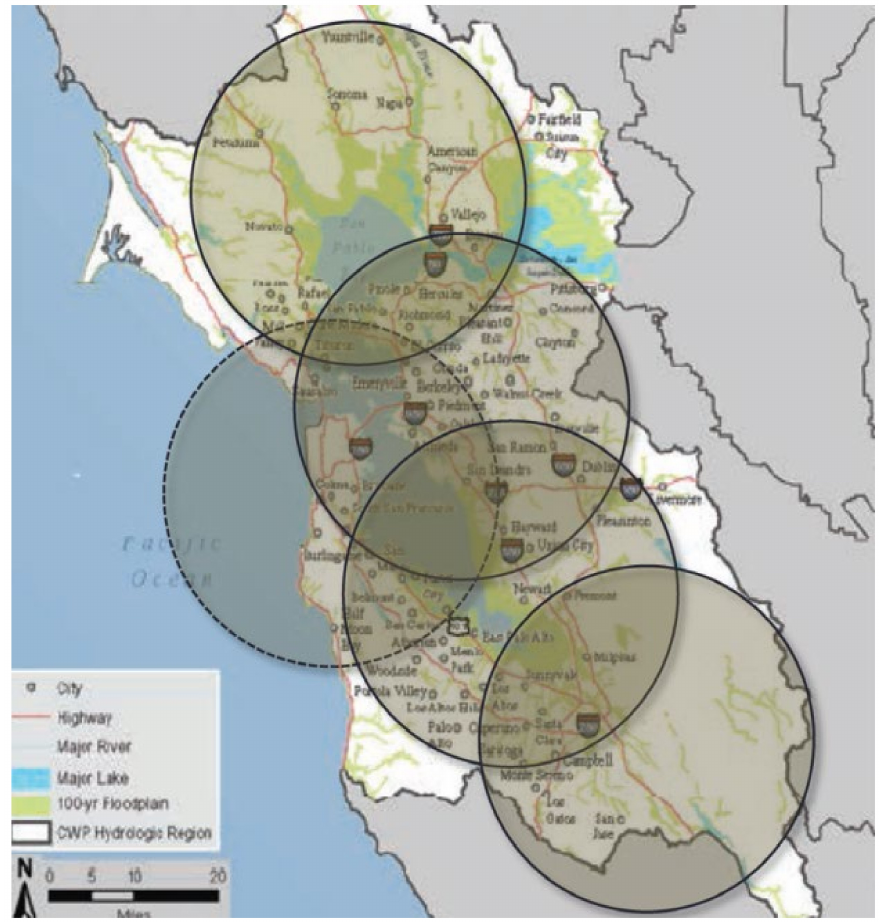
Figure 1. The coverage of the X-band radar system over the San Francisco Bay Area, CA,